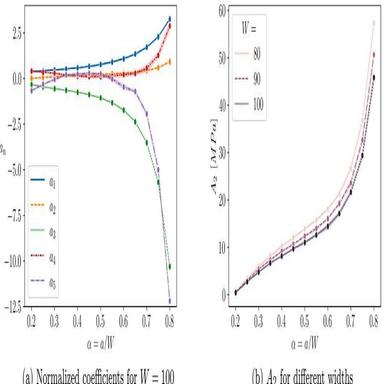
Normalized Williams coefficients 1 , … , 5 for the SECT-specimen parameter study over the whole crack length and for several ∕ ratios.